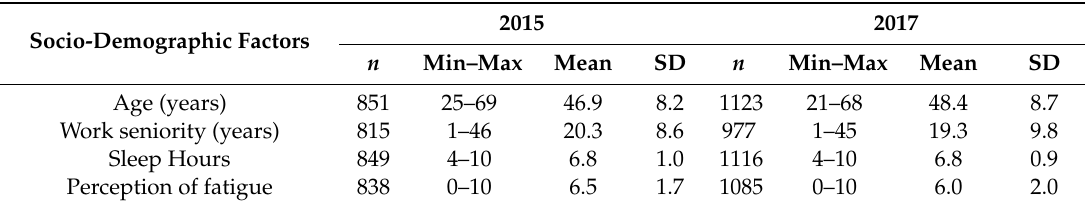
Table 1. Age, seniority, sleep hours, and perception of fatigue among study participants in 2015 and 2017.